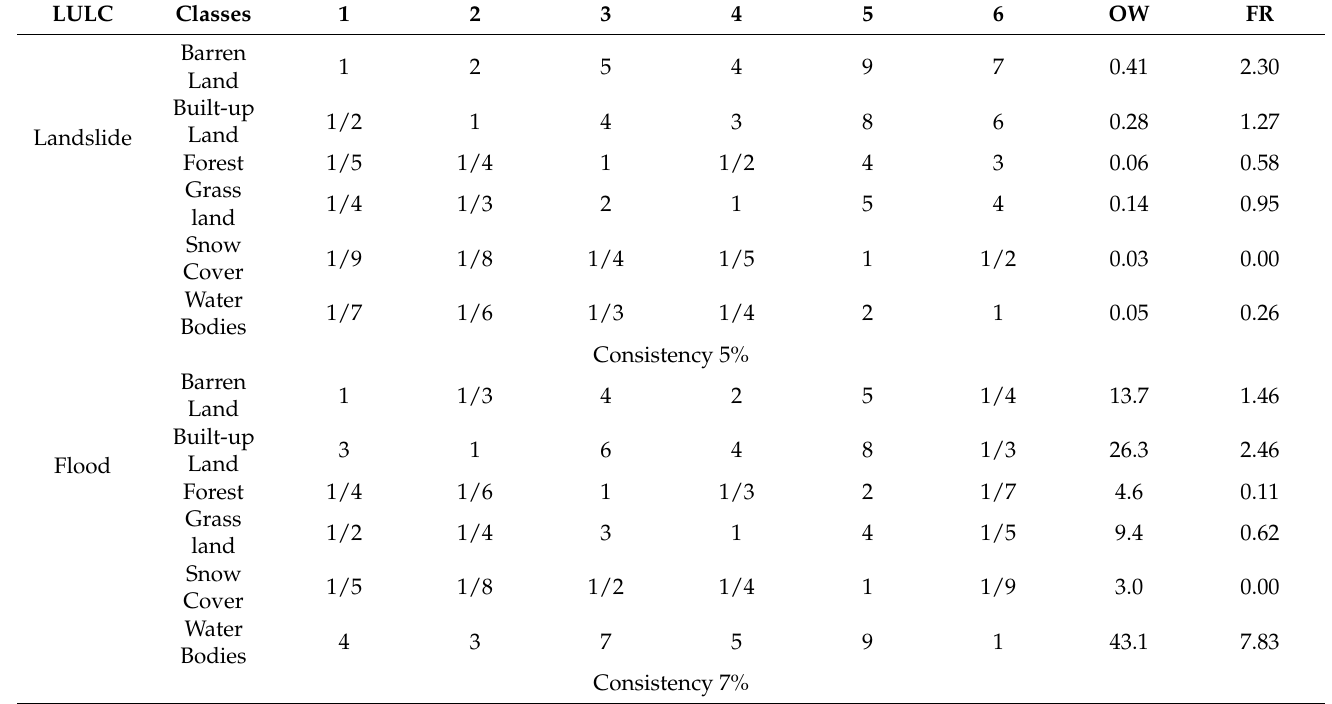
Table 12. AHP matrices and OWs for the LULC causative factor classes.